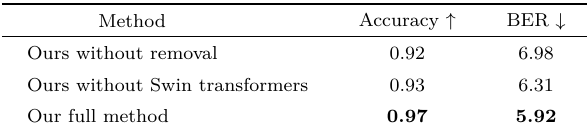
Table 3 Quantitative comparison of detection network settings. The best result in each case is shown in